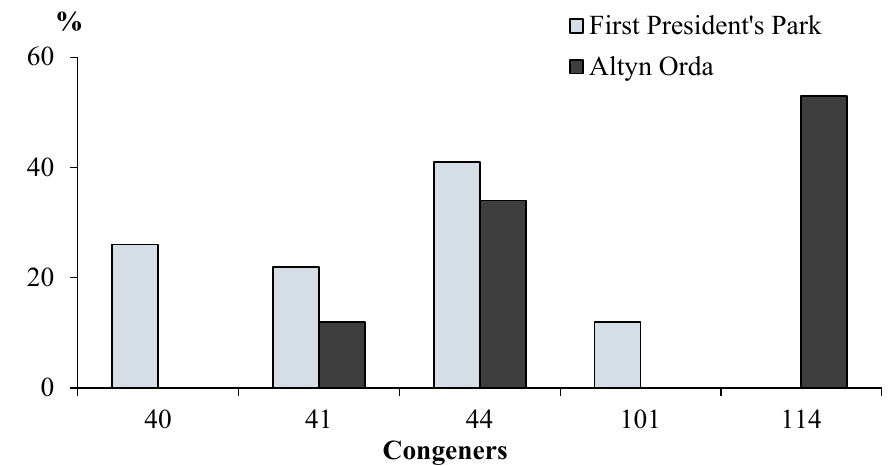
Figure 5. Relative content of PCB congeners in the SC of Almaty territory.